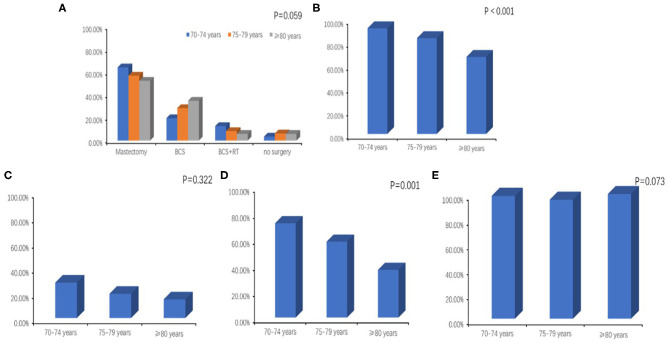
(A) Breast surgery with or without local radiotherapy by age. BCS, breast conserving surgery; RT, radiotherapy. (B) Axillary surgery (axillary lymph node dissection or sentinel lymph node biopsy) by age. (C) Regional lymph node radiotherapy by age. (D) Administration of chemotherapy according to age among patients with positive lymph nodes or triple-negative or HER-2 positive tumors. (E) Administration of endocrine therapy by age.